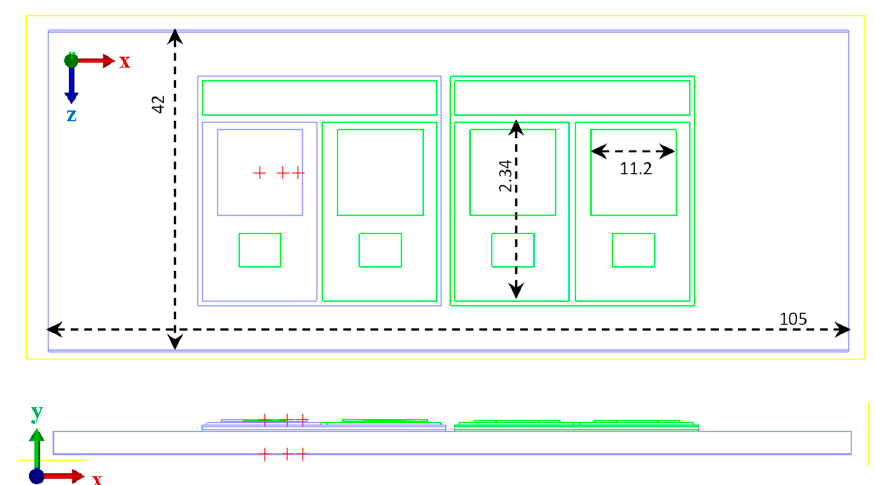
Figure A1. Sketch of the power module on the cold plate from the simulation study in Section 3. Stack composition and the size of elements are listed below in Table A2. Temperature monitor points are marked with “+”. Table A2. Stack composition and the size of elements in the example in Section 4: x, z—lateral size, y—thickness in the stack, V—volume of the element, c V —volumetric specific heat, C th —thermal